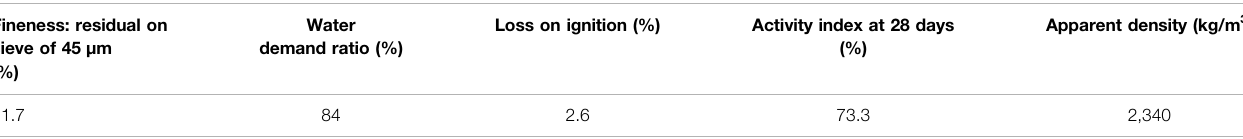
TABLE 2 | Physical properties of fl y ash. Fineness: residual on sieve of 45 μ m